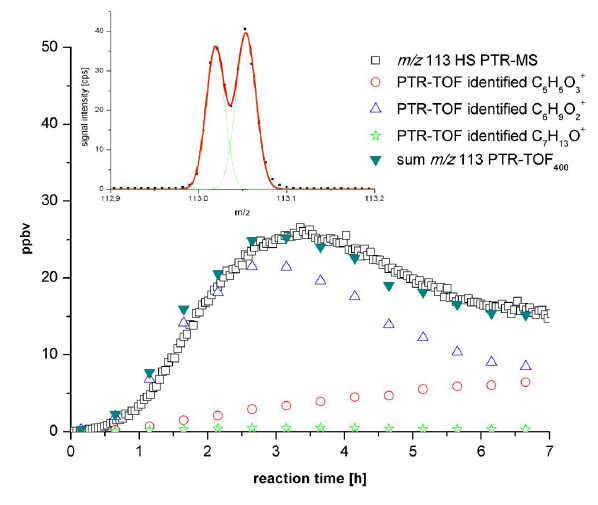
Fig. 2. Time evolution of highly mass resolved PTR-TOF 400 data Figure 2. Time evolution of highly mass resolved PTR-TOF 400 data of three m/z 113 isobars 2 of three m/z 113 isobars (C 5 H 5 O + (C 5 H 5 O 3+ , C 6 H 9 O 2+ , and C 7 H 13 O + detected at m/z 113.023, m/z 113.060 and m/z 113.096, 3 tected at m/z 113.023, m/z 113.060 and m/z 113.096, respectively) respectively) compared to unit mass resolution data from a HS PTR-MS instrument. The inset 4 compared to unit mass resolution data from a HS PTR-MS instru- ment. The inset illustrates the raw spectrum after 7h of reaction illustrates the raw spectrum after 7h of reaction time between m/z 112.9 and m/z 113.2 (black 5 time between m/z 112.9 and m/z 113.2 (black squares), the fits of squares), the fits of each detected ion (green line) and the superposition of the total ion signal 6 each detected ion (green line) and the superposition of the total ion (red line). 7 signal (red